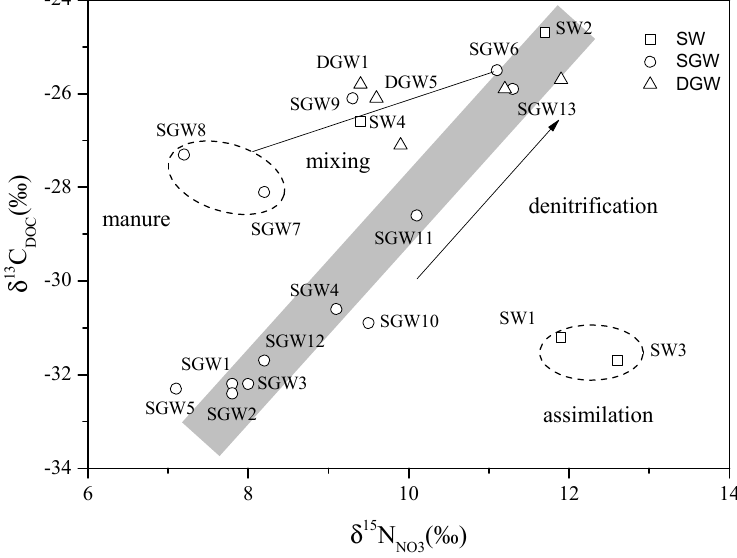
Figure 10. Plot of δ 13 C DOC and δ 15 N NO3 in surface water and groundwater. The rectangle with gray shadow indicates the synergic trend between δ 13 C DOC and δ 15 N NO3 . The two ellipses with dashed lines highlight the values deviating from the trend due to mixing with different sources and assimilation by microbial activities. (SW: Surface water; SGW: Shallow groundwater; DGW: Deep